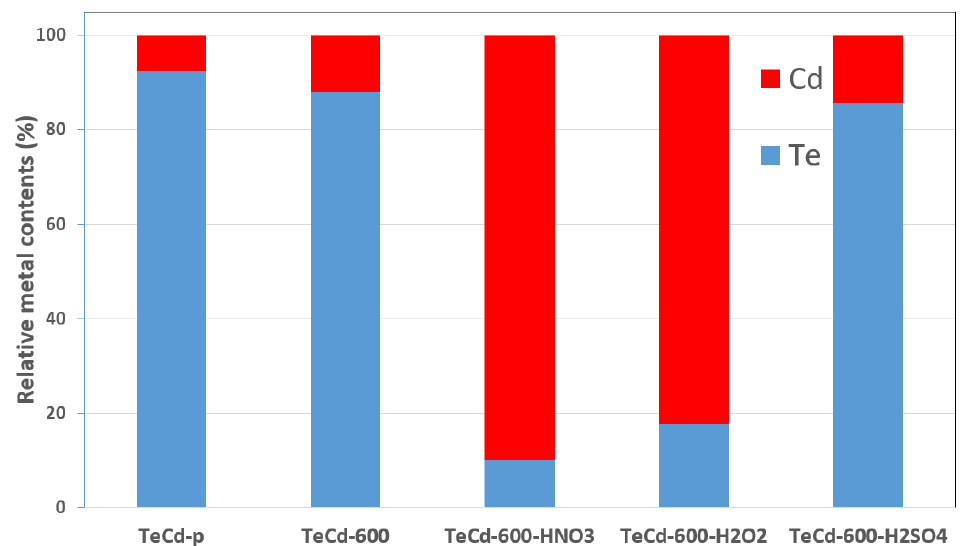
Figure 5. Estimated relative Te and Cd metal atomic contents in the samples based on XPS measurements: before (TeCd-p) and after thermal treatment (TeCd-600), and after leaching for 2h at 50 °C in 1 M H 2 SO 4 (TeCd-600-H2SO4), 3M HNO 3 (TeCd-600-HNO3), and 30% H 2 O 2 (TeCd-600- H 2 O 2 ).